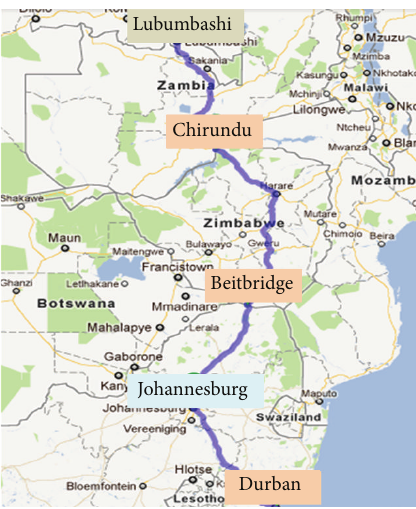
Figure 2: North-South corridor across South Africa, Zimbabwe, and